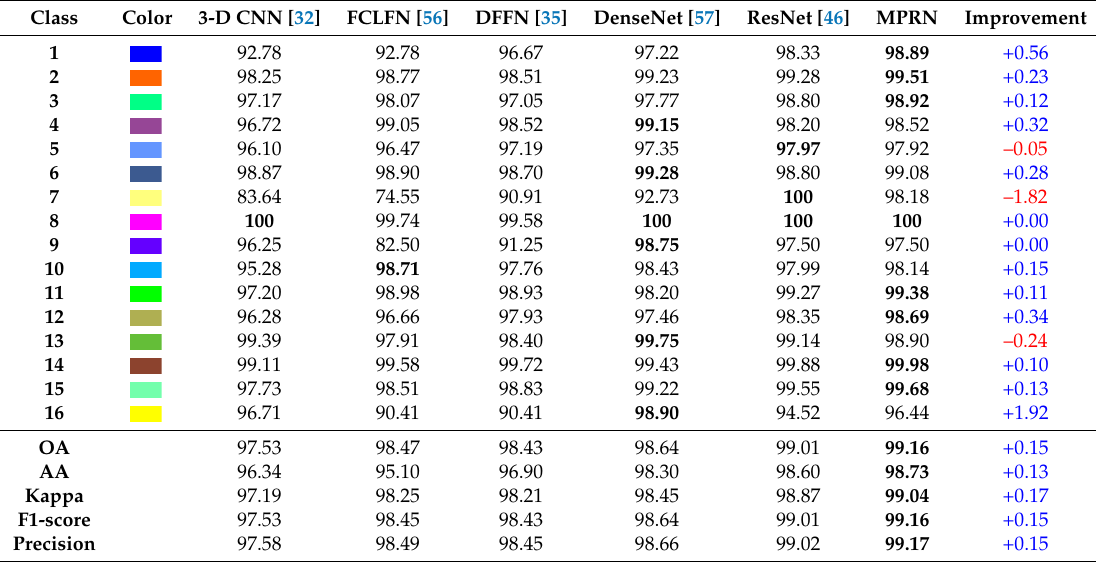
Table 4. Classification accuracies (%) obtained by different methods on the Indian Pines data set. The improvement of MPRN over ResNet is also provided. The best results are highlighted in bold font. In addition, the positive and negative improvements are marked in blue and red,